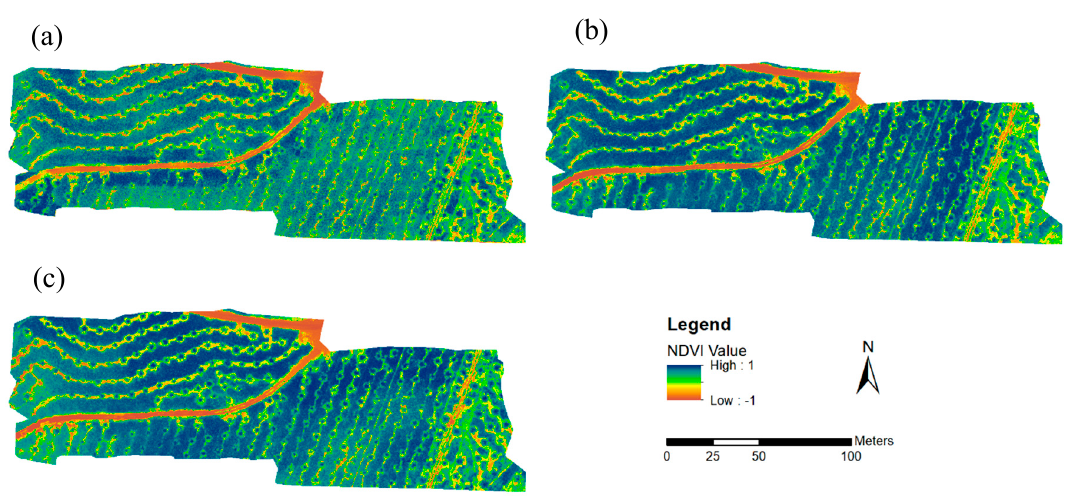
Figure A3. Normalized Difference Vegetation Index (NDVI) for ( a ) 20 m, ( b ) 60 m and ( c ) 80 m altitude.